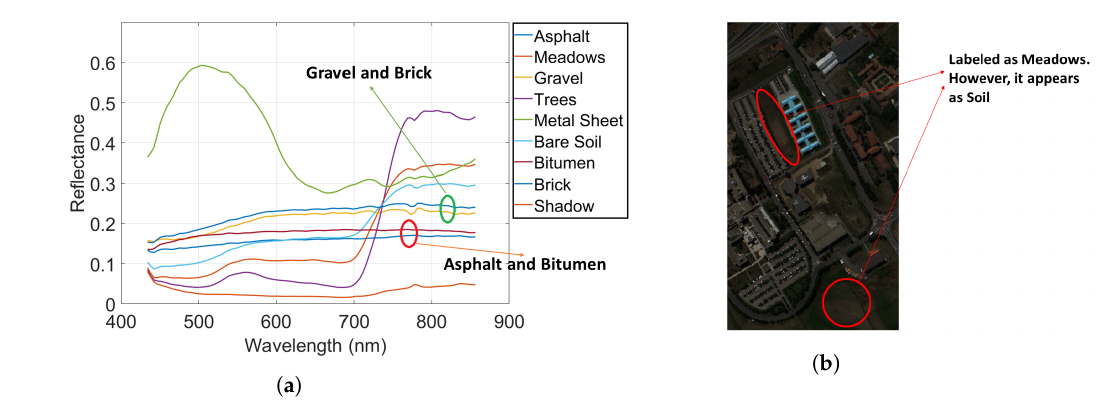
Figure 22. Spectral similarities in Pavia image: ( a ) spectral signatures highlighting similarities; ( b ) spatial location of spectrally similar information